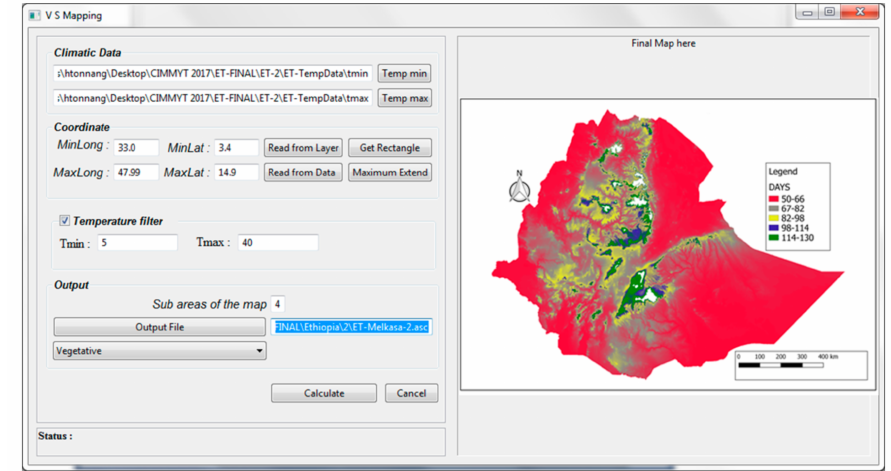
Figure 7. PPMaP window showing the mapping section of the software. The paths for inputting minimum and maximum temperatures are shown. Below these paths are the geographical coordinates of the region chosen for mapping. The map of Ethiopia showing the number of days a maize variety could spend during the vegetative phase appeared in a box at right. Depending on the location, this maize variety can spend from 50 to 130 days to start